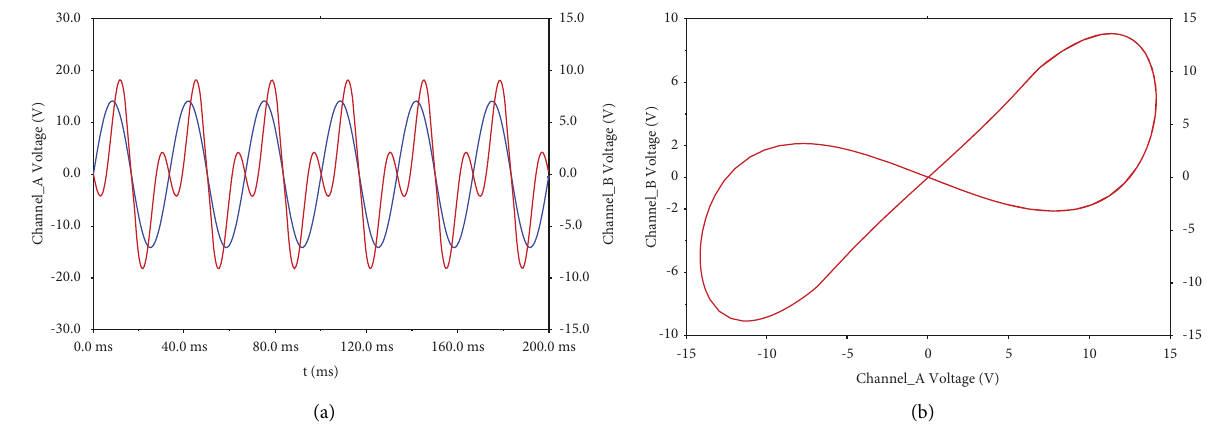
Figure 2: Absolute memristor hysteresis loop. (a) t ( s ) − v ( t ) curve; (b) v ( t ) − i ( t )